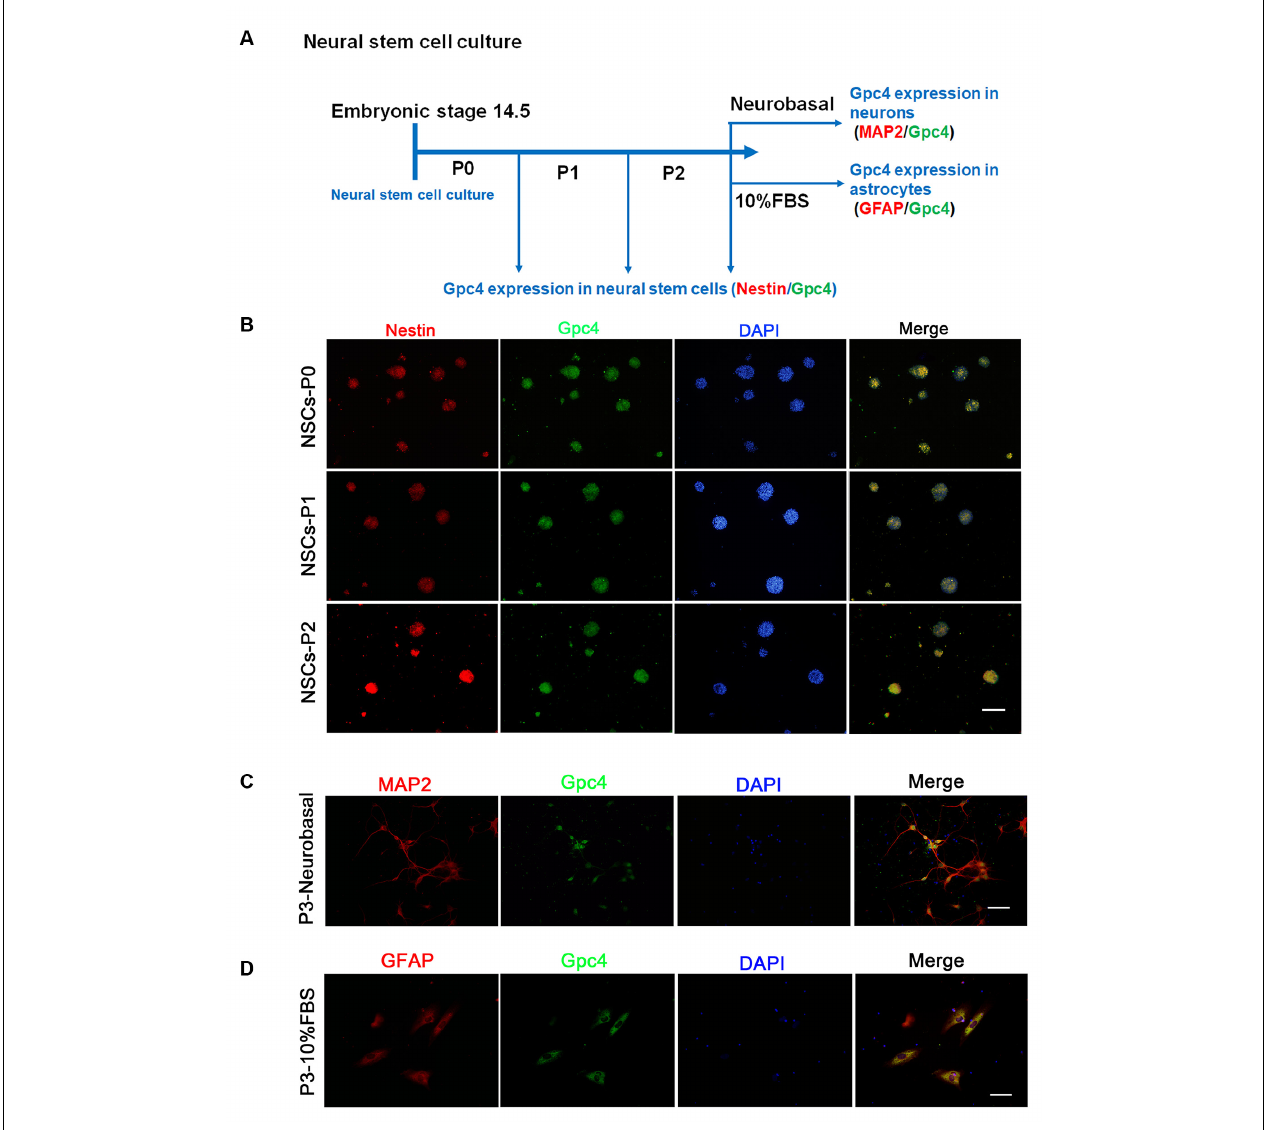
FIGURE 1 | Expression of Gpc4 in neural stem cells (NSCs). (A) The schedule for detecting Gpc4 expression in NSCs and differentiated neurons and astrocytes. (B) At P0, P1, and P2, Gpc4 (green) colocalized with nestin (red) in the neural spheres. (C,D) NSCs were differentiated using neural basal medium containing B27 or DMEM/F12 containing 10% FBS. MAP2 (red) and GFAP (red) were used to illustrate Gpc4 (green) expression in neurons and astrocytes, respectively. Gpc4, glypican 4; DMEM/F12, Dulbecco’s Modified Eagle Medium/Nutrient Mixture